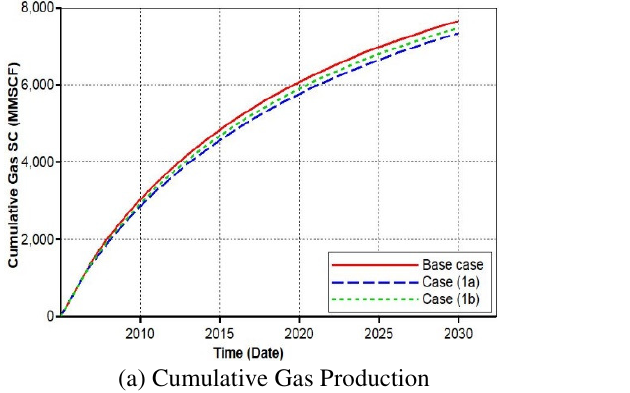
FIG. 3. INFLUENCE OF THE FRACTURE